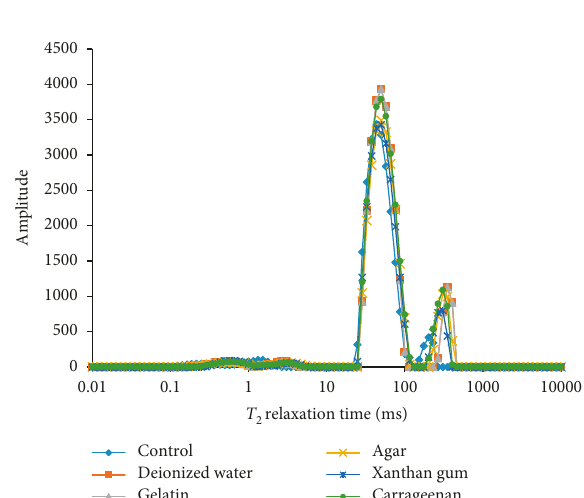
Figure 3: Distribution of multiexponentially fitted T time spectra of normal, water-injected, and hydrocolloid-injected pork.